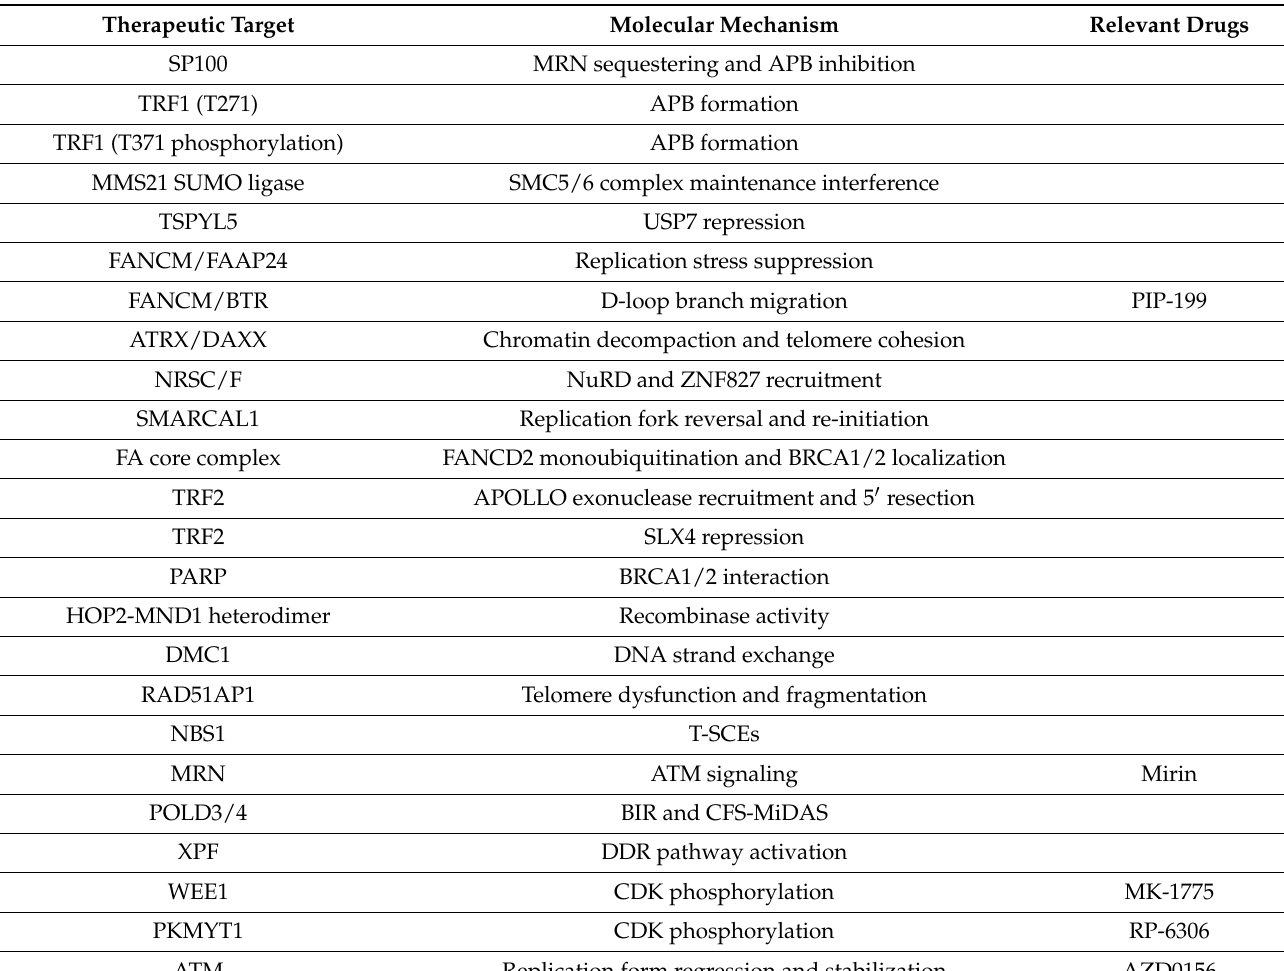
Table 1. ALT Therapeutic